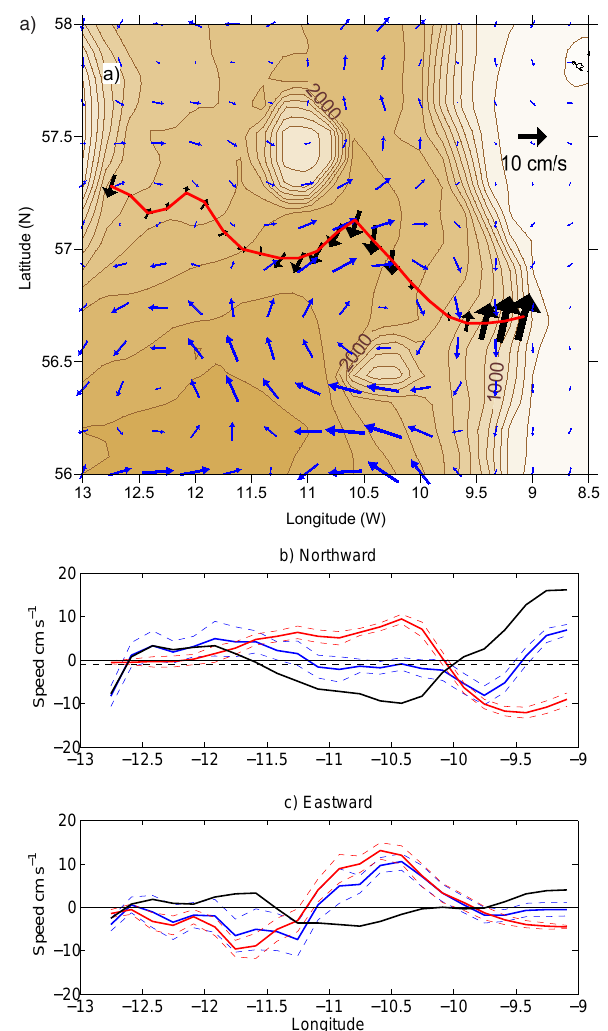
Figure 12. (a) MDT currents from Aviso (thin blue arrows) and mean absolute current along the glider track derived from (A5) (thick black arrows). (b) Northward and (c) eastward currents from simultaneous Aviso (red) and glider (blue) observations averaged over the whole mission into 10 (cid:48) longitude bins, with the dashed lines being the standard error in the mean. The black lines are the differ- ence between the Aviso currents that are displayed as vectors in (a) . The lower horizontal line in (b) is an estimate of the offset of the y axis origin to account for the mean current through the